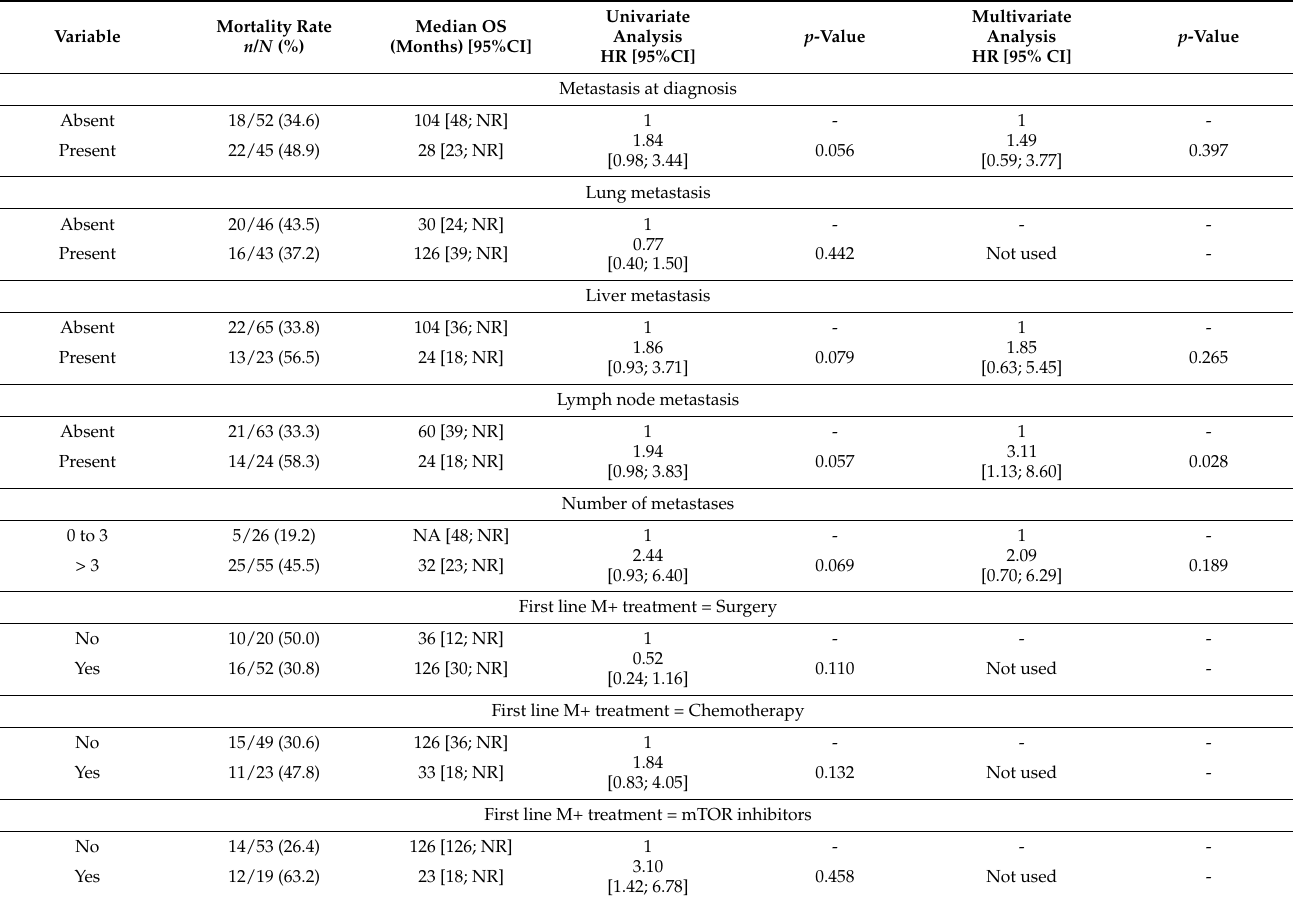
Table 6. Univariate and multivariate analyses of metastases features and type of first line treatment in the metastatic population related to OS ( N = 111). Multivariate analyses on 65 patients.